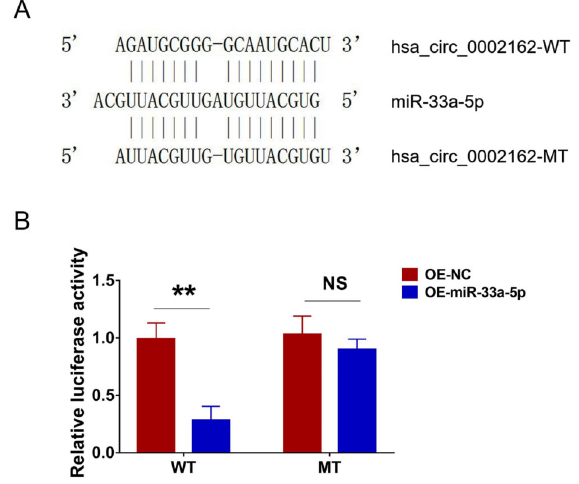
Figure 9. A , Designed sequences between hsa_circ_0002162 WT/MT and miR-33a-5p. B , Comparison of the relative luciferase activity between WT & OE-miR-33a-5p group and WT & OE-NC group, as well as between MT & OE-miR-33a-5p group and MT & OE-NC group. Data are reported as means ± SD. **P o 0.01 ( t -test). NS: not signi fi cant; NC: negative control; WT: wild type; MT: mutant type; miR: microRNA; circ: circRNA; OE: